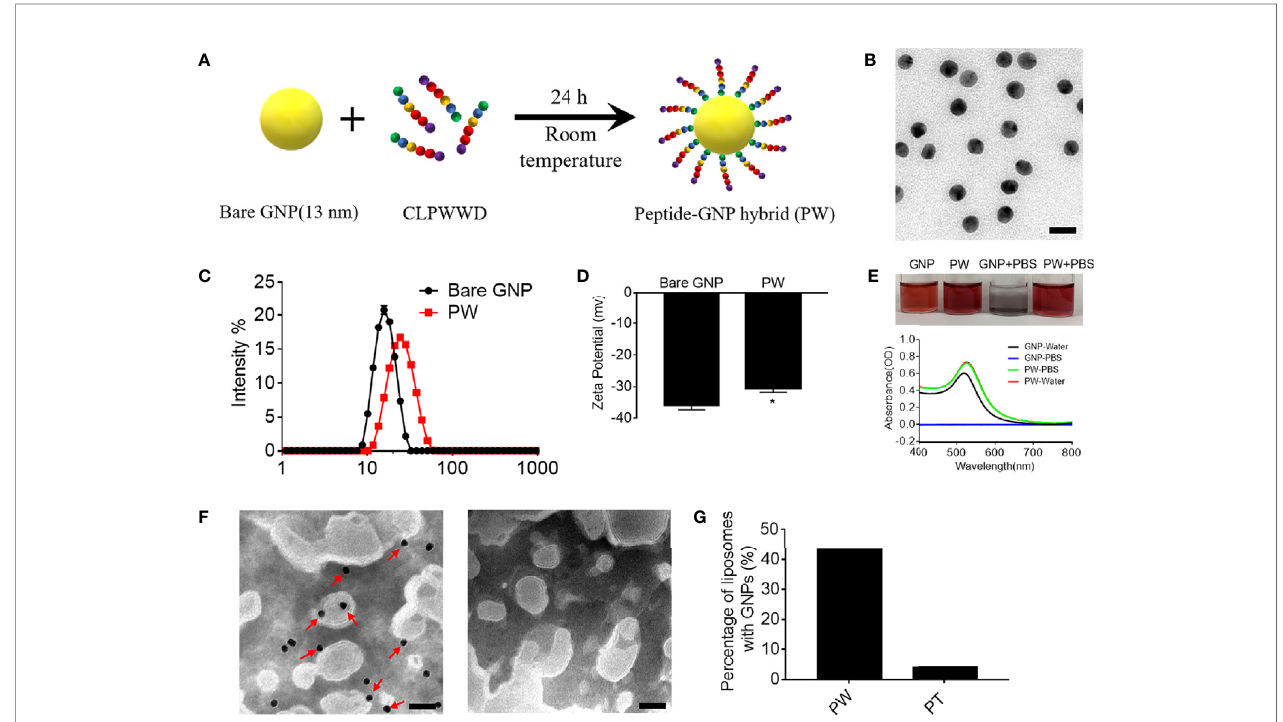
FIGURE 1 | Preparation of the peptide-GNP hybrid PW and its physicochemical characterization. (A) A schematic diagram of the synthesis of the peptide-GNP hybrid PW. (B) The TEM image of PW; scale bar = 20 nm. (C) The size distribution of the bare GNP and PW. (D) The zeta-potential of the bare GNP and PW. (E) The photograph (top) and UV-Vis spectra (bottom) showing the stability of bare GNP and PW in water and PBS. (F) The TEM images of the nano-hybrids PW (left) and PT (right, coated with the peptide CLPTTD) with liposomes showing that PW tends to interact with liposomes, but the control nano-hybrid PT does not; scale bar = 50 nm, PW, PT = 5 nM, phospholipid = 1.67 mg/mL. (G) The percentage of liposomes interacting with the nanohybrids; over 200 liposomal vesicles were counted. N ≥ 3, *p <